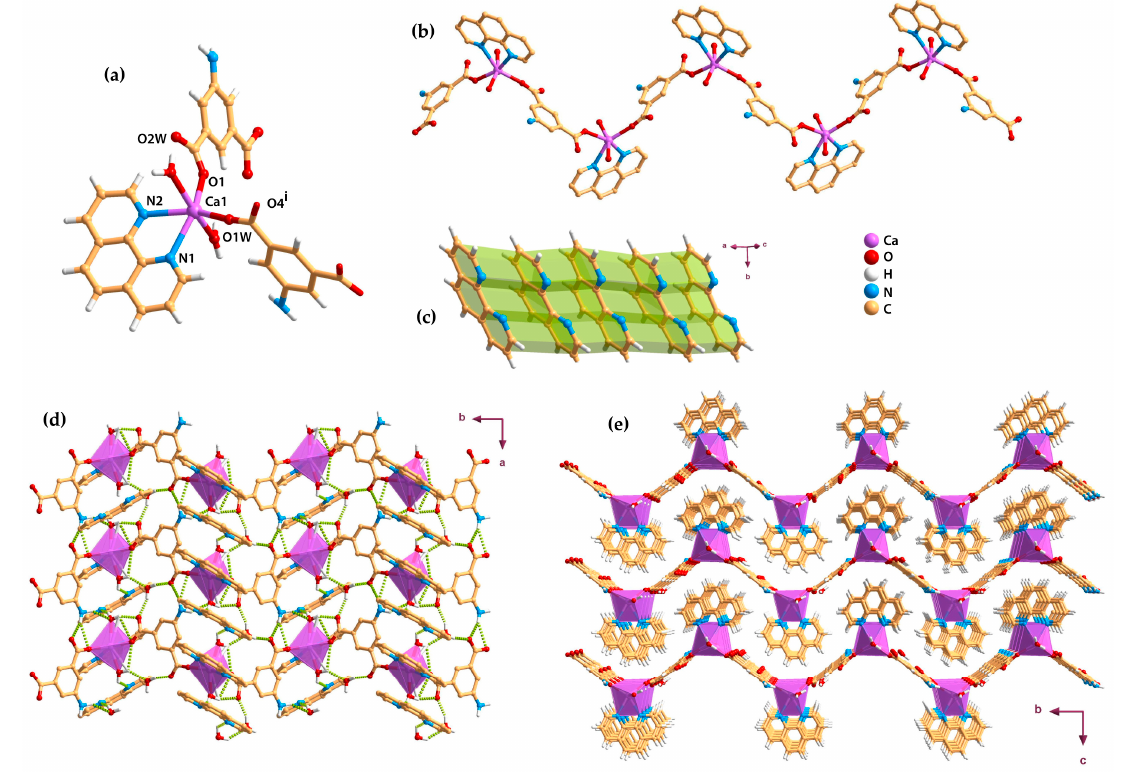
Figure 4. ( a ) Coordination environment for the Ca1 center in the crystal structure [Ca(aip)(phen)(H 2 O) 2 ] · (phen) · (H 2 O) ( 4 ), with the labelling scheme for the atoms of the coordination sphere; ( b ) zig-zag 1D metal–organic chain; ( c ) π ··· π stacking between adjacent coordinated and uncoordinated phen molecules; ( d ) 2D supramolecular layer extended in the ab plan of the unit cell; and ( e ) extended packing viewed in the [1 0 0] direction of the unit cell.